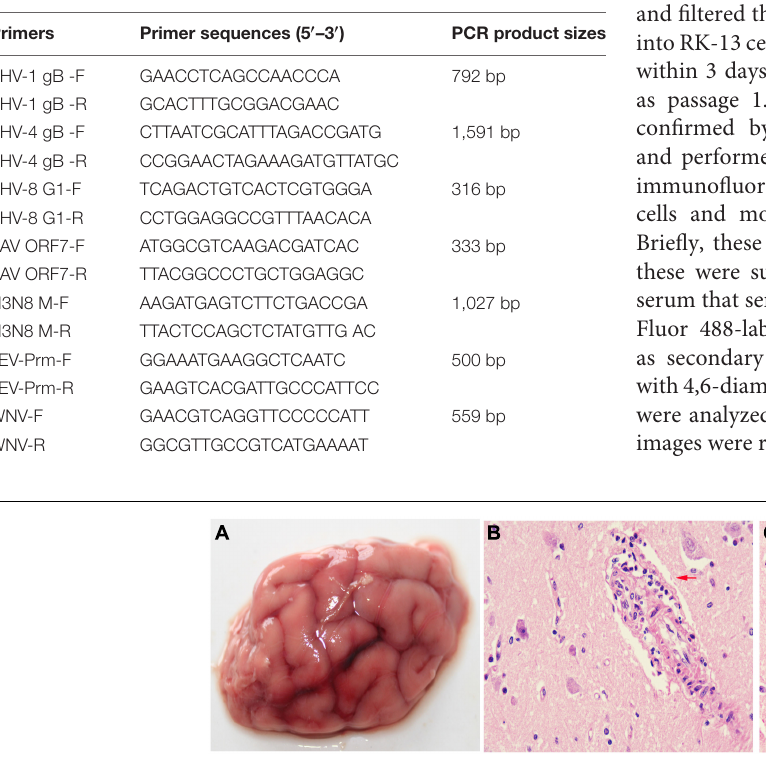
Frontiers in Microbiology |